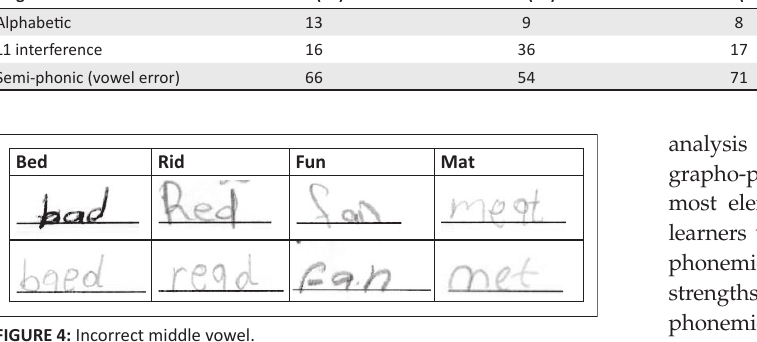
FIGURE 4: Incorrect middle vowel.